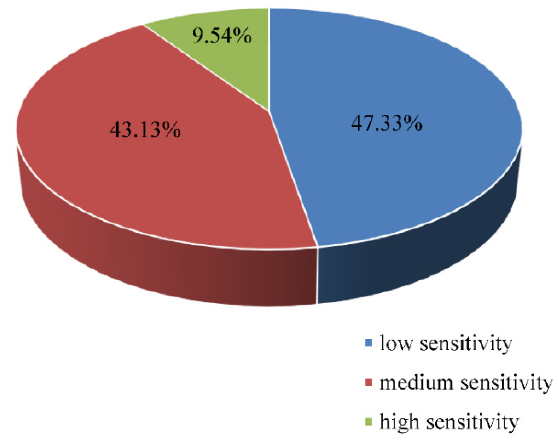
Figure 3. Distribution of sensitivity categories.